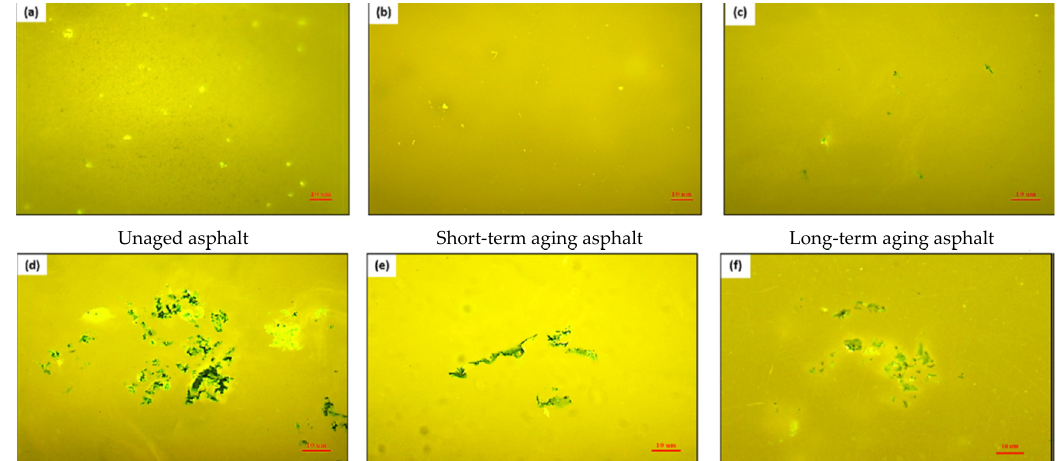
Figure 2. Segregation test result of different blended asphalt: ( a ) virgin blended asphalt with WCO and rubber asphalt; ( b ) short-term aged blended asphalt with WCO and rubber asphalt; ( c ) long-term aged blended asphalt with WCO and rubber asphalt; ( d ) virgin rubber asphalt; ( e ) short-term aged rubber asphalt; ( f ) long-term aged rubber asphalt